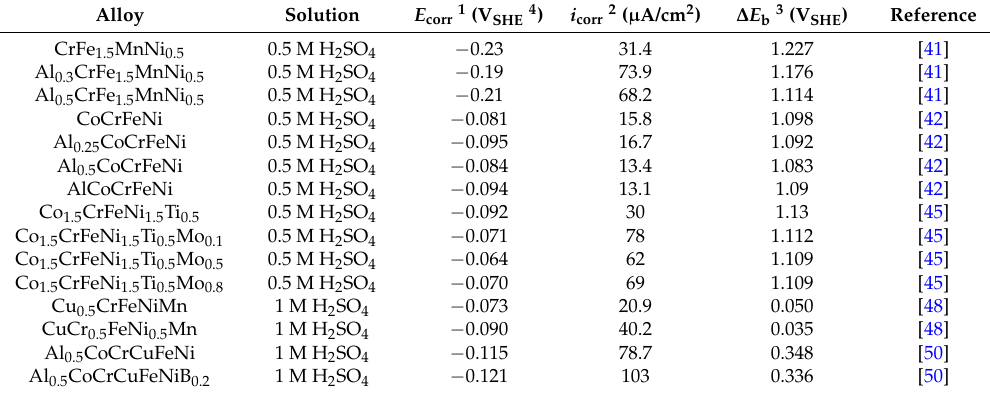
Table 2. Electrochemical parameters of HEAs in the acid solution at room